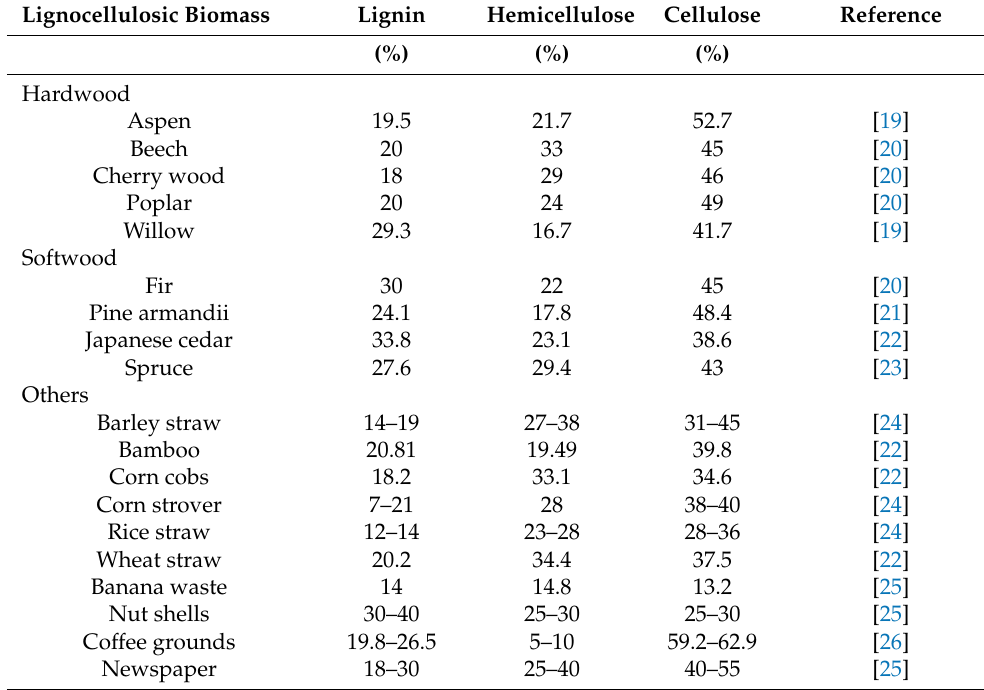
Table 1. Relative composition of lignocellulosic